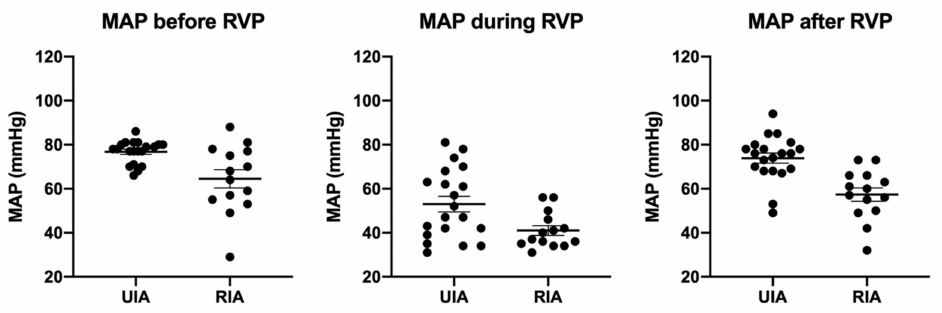
Figure 4. Throughout all phases, MAP was significantly lower in the rIA group.